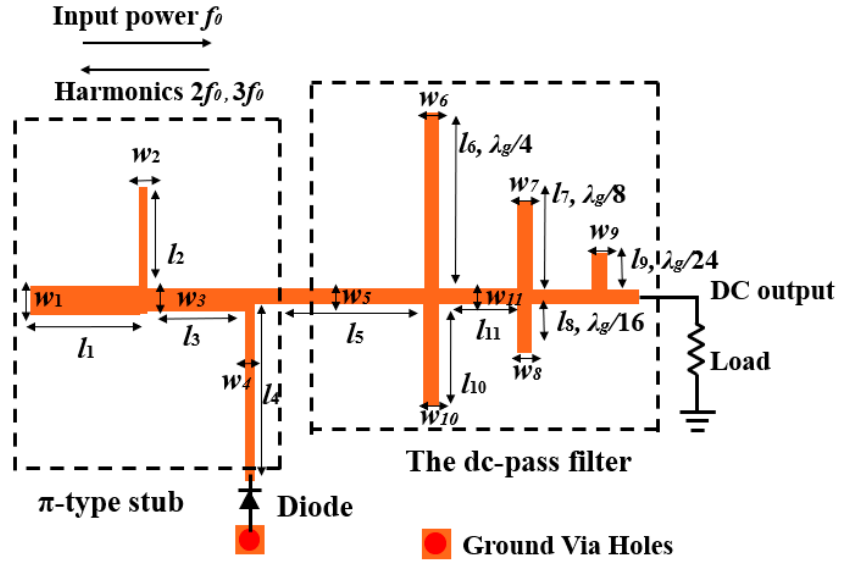
Figure 2. The schematic of the rectifier utilizing the 2nd and 3rd harmonic ： l 1 = 4.7 mm, l 2 = 4.7 mm, l 3 = 4.2 mm, l 4 = 8.3 mm, l 5 = 9.2 mm, l 6 = 9.2 mm, l 7 = 4.5 mm, l 8 = 2.2 mm, l 9 = 1.5 mm, l 10 = 4.8 mm, l 11 = 4.5 mm, w 1 = 1.7 mm, w 2 = 0.55 mm, w 3 = 1.5 mm, w 4 = 0.5 mm, w 5 = 1 mm, w 6 = 1 mm, w 7 = 1